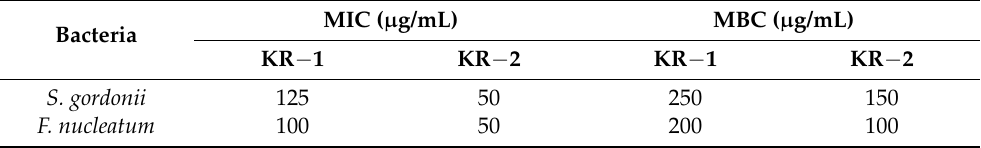
Table 1. In vitro susceptibility of S. gordonii and F.nucleatum to KR − 1 and KR − 2.